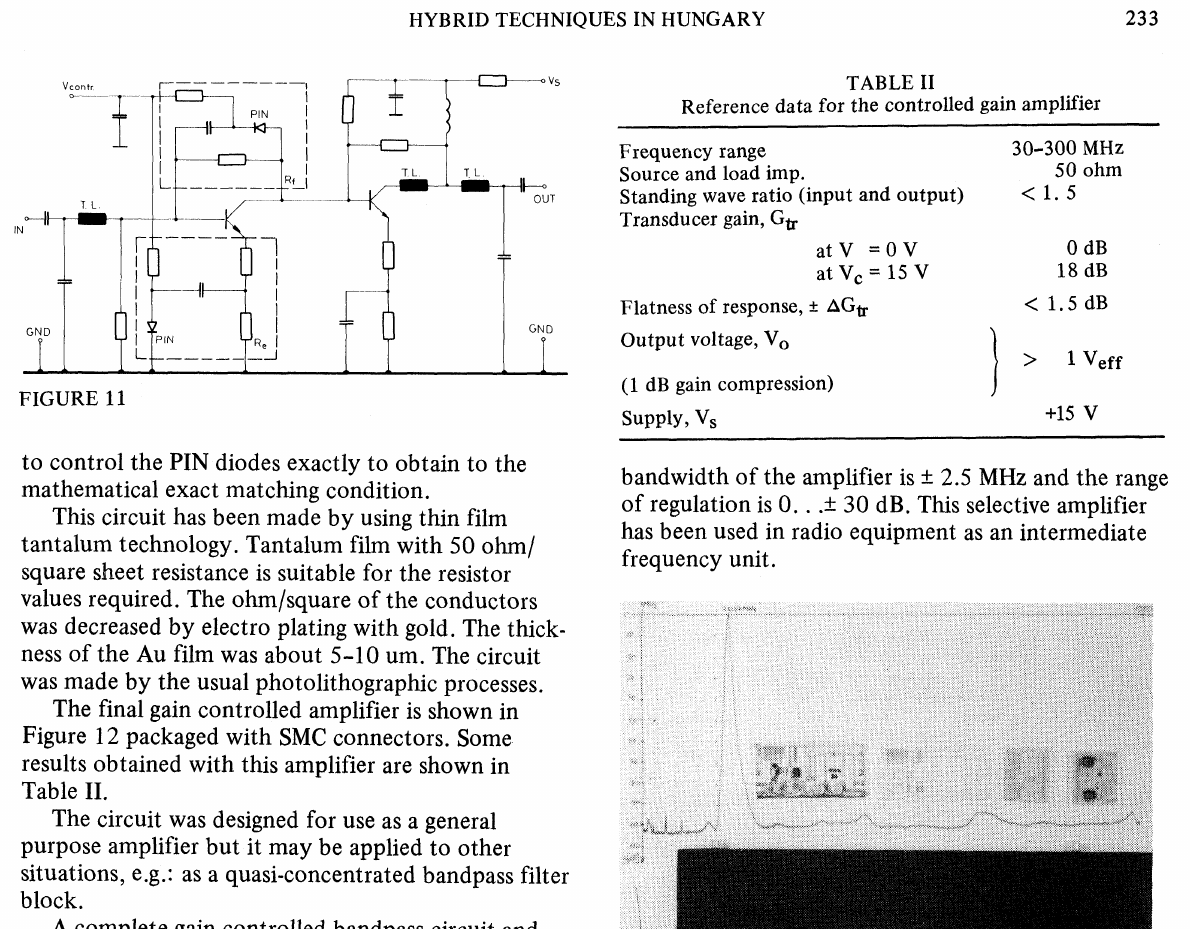
TABLE II Reference data for the controlled gain amplifier